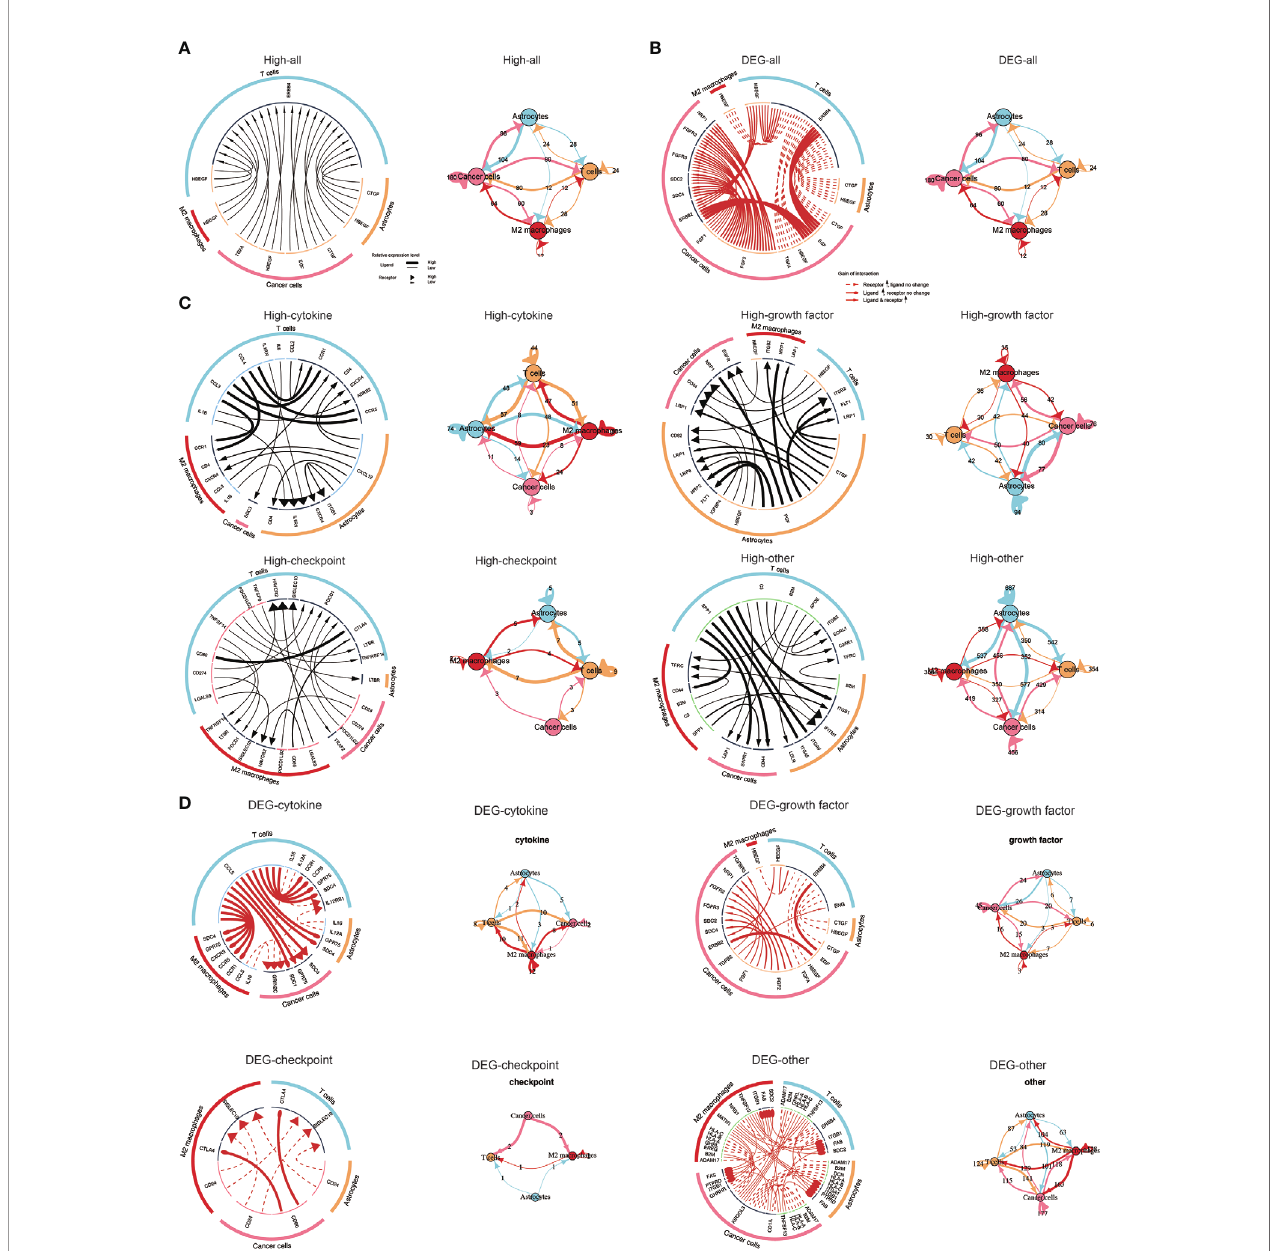
FIGURE 7 | Visualization of cell communication. (A) Network plot and circos plot showing the total ligand-receptor interactions detected between each two different cell types and/or within the same cell type in high TNFSF13 group. (B) Network plot and circos plot showing the total ligand-receptor interactions detected between each two different cell types and/or within the same cell type based on the differentially expressed genes between high TNFSF13 group and low TNFSF13 group. (C) Network plot and circos plot showing the four types of ligand-receptor interactions detected between each two different cell types and/or within the same cell type in high TNFSF13 group. (D) Network plot and circos plot showing the four types of ligand-receptor interactions detected between each two different cell types and/or within the same cell type based on the differentially expressed genes between high TNFSF13 group and low TNFSF13